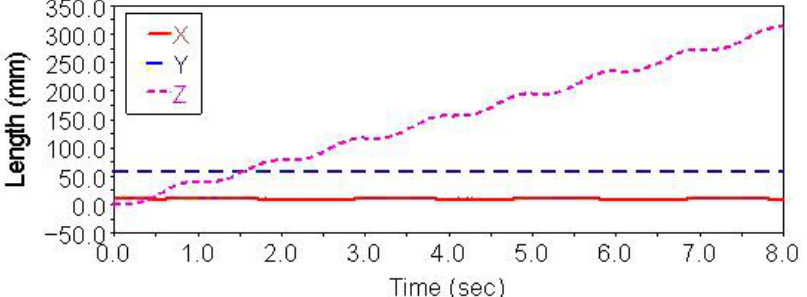
Figure 5. Centroid displacement curve of straight gait.